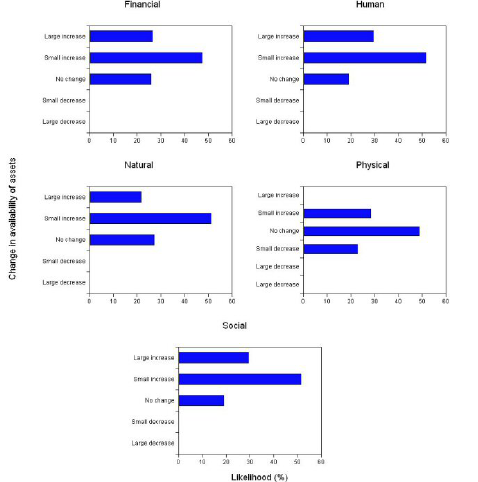
Fig. A7.2. The impacts of commercialization on availability of assets, as predicted by the BBN, for the case study of Hongos (Cuajimoloyas). These outputs were generated by instantiating the network with factor values for these individual case studies (see